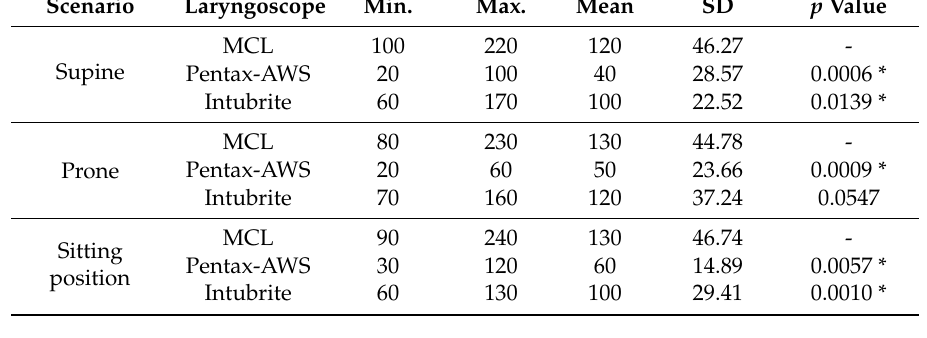
Table 3. Pressure created on the tongue during intubation in simulated di ff erent positions [mmHg]. (Min-minimum, Max-maximum, SD-standard deviation). MCL-Macintosh Laryngoscope, * p value when compared with the MCL (control group).